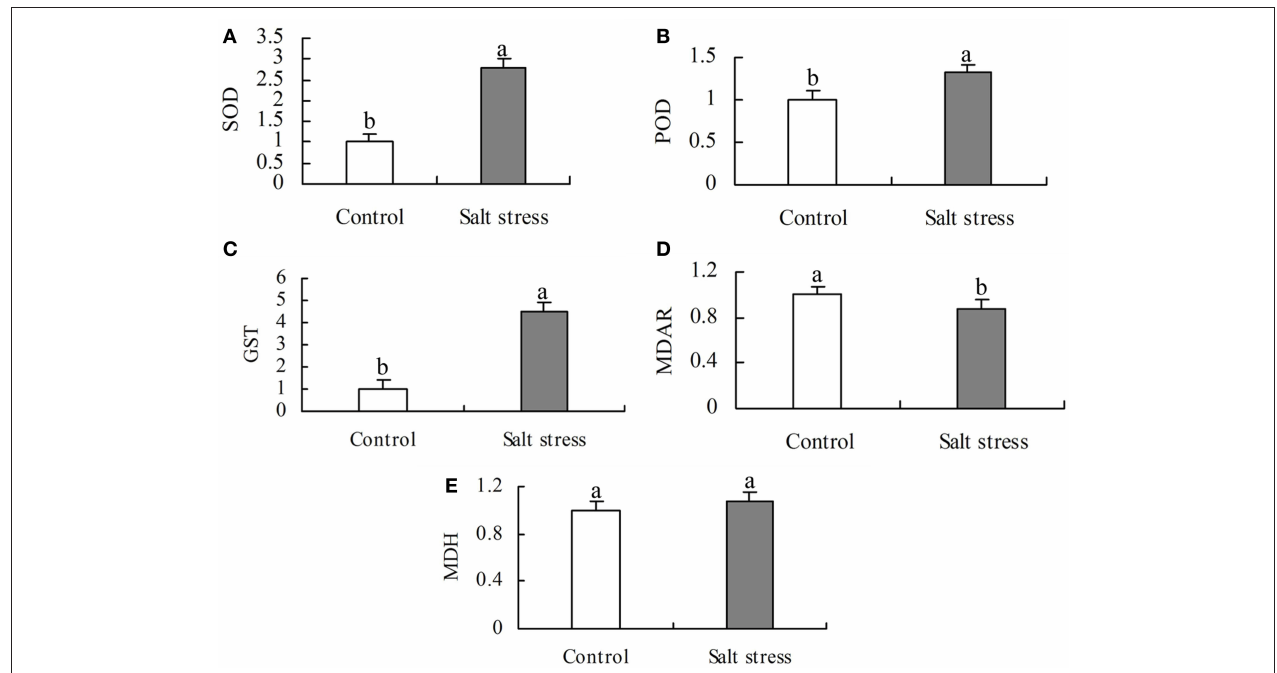
FIGURE 5 | Relative abundances of (A) superoxide dismutase (SOD), (B) peroxides (POD), (C) glutathione S-transferase (GST), (D) monodehydroascorbate reductase (MDAR), and (E) malate dehydrogenate (MDH) in salt stress and control roots revealed by qRT-PCR. Bars represent mean ± SE ( n = 3 ). Different letters above the bars indicate a significant difference at P < 0 . 05